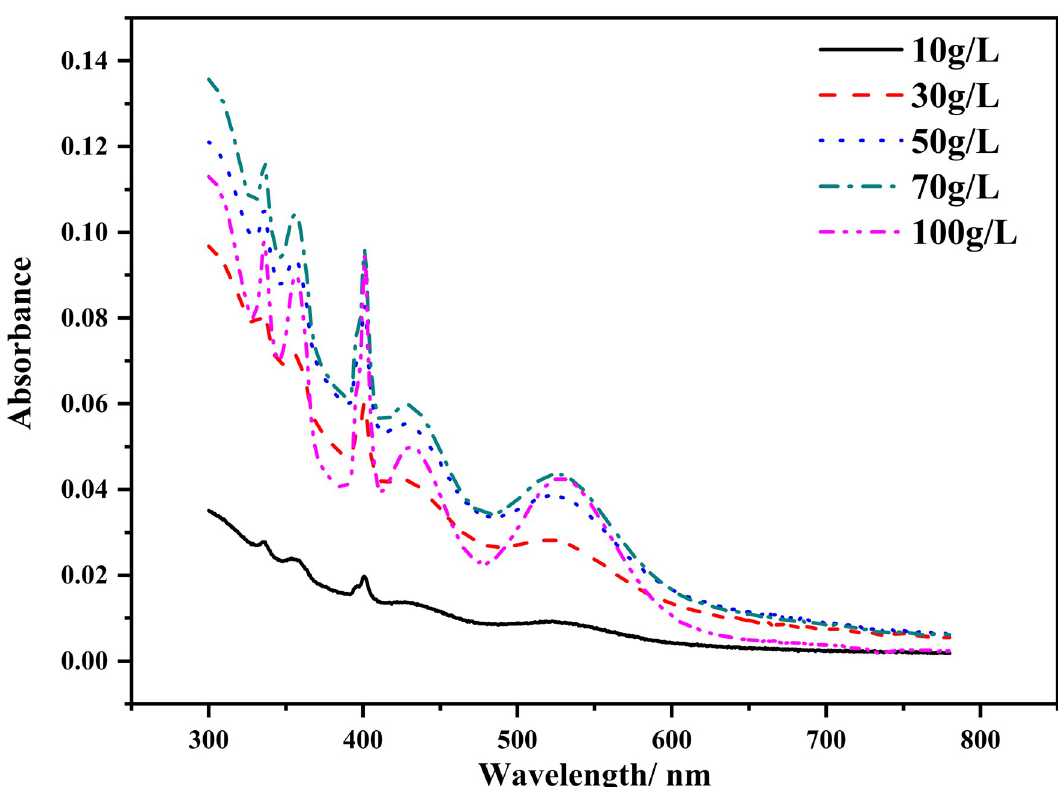
Fig 2. Spectra of MnSO 4 solutions of different concentrations without pH